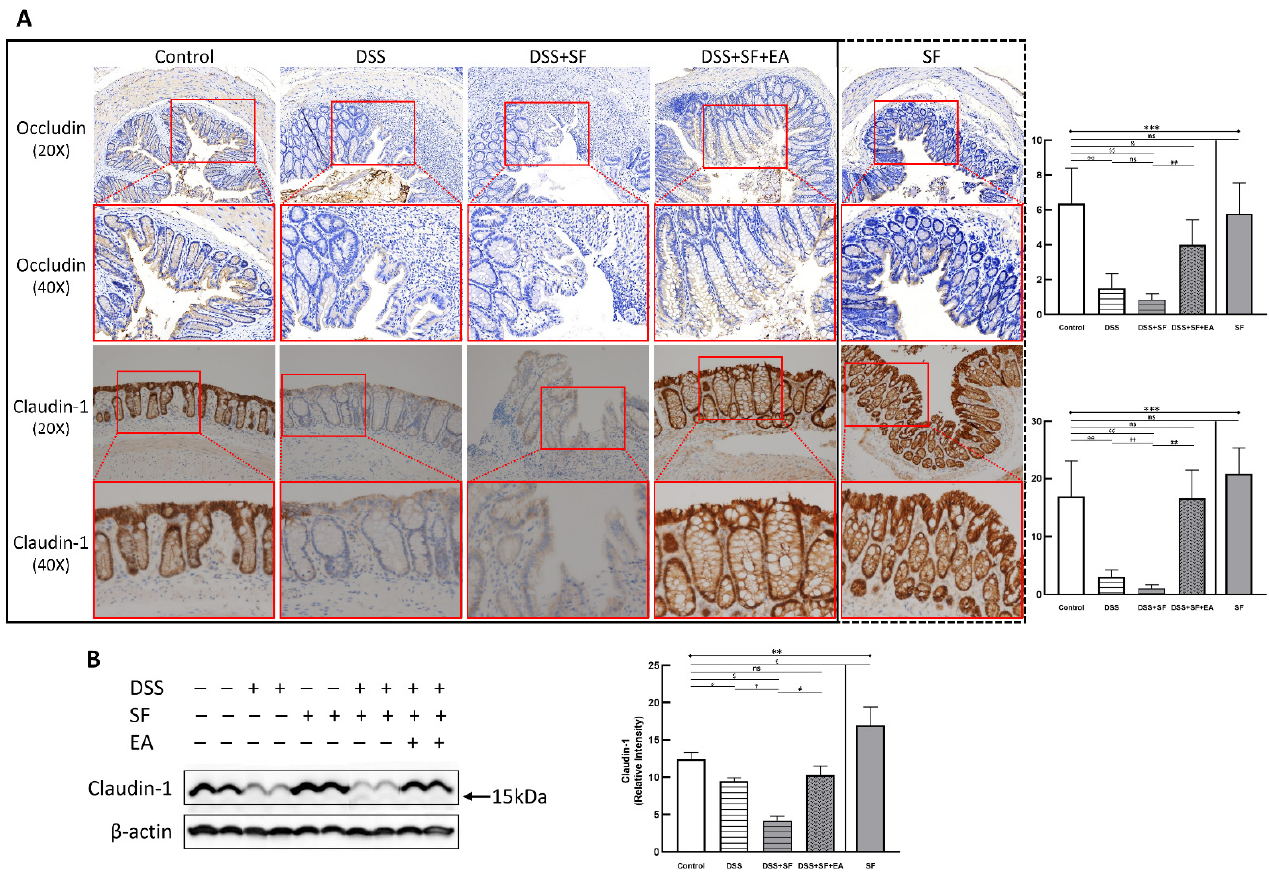
Figure 2. Tight junction proteins in mice colon during DSS colitis with sleep fragmentation. ( A ) Immunohistochemical (IHC) staining of occludin and claudin-1 in colon sections. Upper part: expression of occludin in colon tissue of different groups at 200× & 400× magnification. Comparison of the occludin in five groups was shown in the right upper figure. Lower part: expression of claudin-1 in colon tissue of different groups at 200× and 400× magnification. Comparison of the claudin-1 in five groups was shown in the right lower figure. Quantification of area percentage of IHC staining by true color image analysis with the application of adjusted thresholds. ( B ) Western blot analysis of claudin-1 and β -actin (loading control) in colon homogenates. Right graph indicates quantification relative to β -actin. The uncropped western blot figures were presented in Figure S1. The densitometry readings/intensity ratio of claudin-1 in western blots in DSS-colitis mice with sleep fragmentation were presented in Table S3. * Stands for a result of five groups comparison (represented by bold line segments with endpoints). ✠ , ✟ , #, $, &, and € represent the results of control group versus DSS group, DSS group versus DSS + SF group, DSS + SF group versus DSS + SF + EA group, control group versus DSS + SF group, control group versus DSS + SF + EA group, and control group versus SF group, respectively (represented as a thin line without endpoints). *, ✠ , ✟ , #, $, &, €, p < 0.05; ✠✠ , ✟✟ , ##, $$, p < 0.01; ***, p < 0.001; ns, no significance. Data were presented as mean ± SEM of repeated adjusted thresholds in each group. DSS, dextran sodium sulfate; SF, sleep fragmentation; EA,